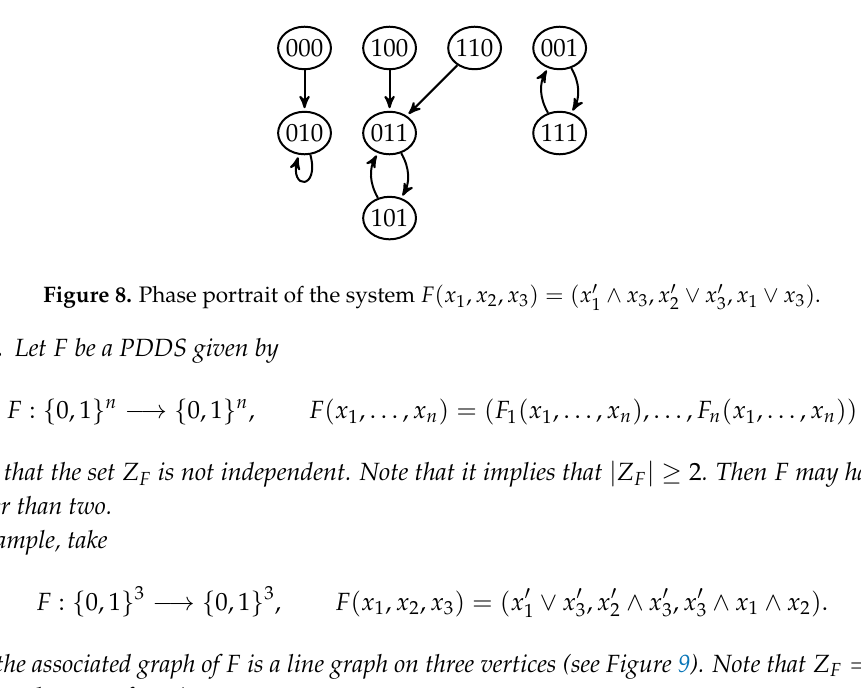
(cid:48) ∧ x ∨ x (cid:48) , x 1 ∨ x 3 ) . 3 , x 2 3 1